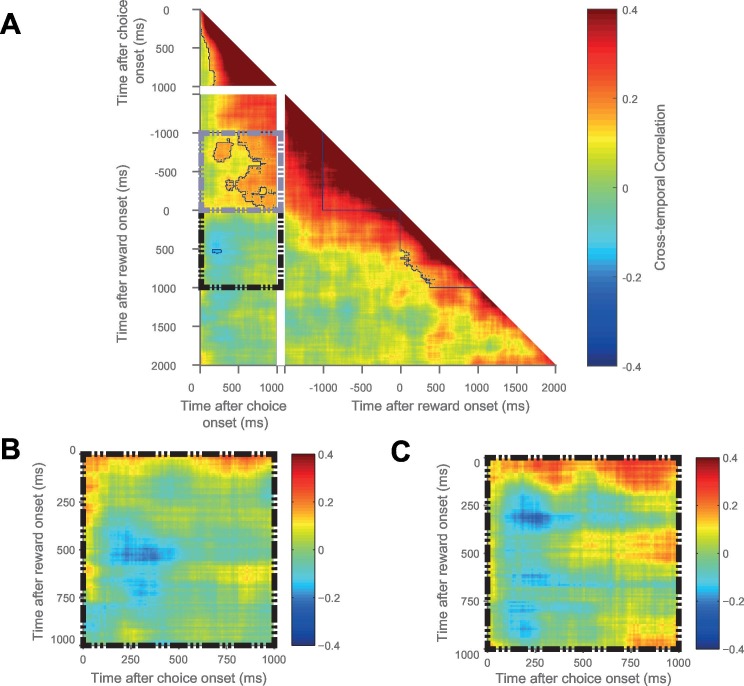
Cross-temporal analysis of ACC activity.Sustained chosen value correlates are present at choice and outcome, but sustained coding from choice through outcome is absent. However, there appears to be maintenance of chosen value coding from choice until the period immediately preceding reward delivery (grey dashed box). Blue lines indicate a significant area of cross-correlation (p<0.05, see Materials and methods). (B and C) The black dashed inset (bottom left quadrant in A) is then performed in high (B) and low (C) time constant ACC neurons separately. There is no evidence for sustained coding from choice through outcome in either low or high time constant cells. This contrasts with an OFC (Figure 5C–D), where the sustained code from choice is also present through reward delivery specifically in high time constant neurons.